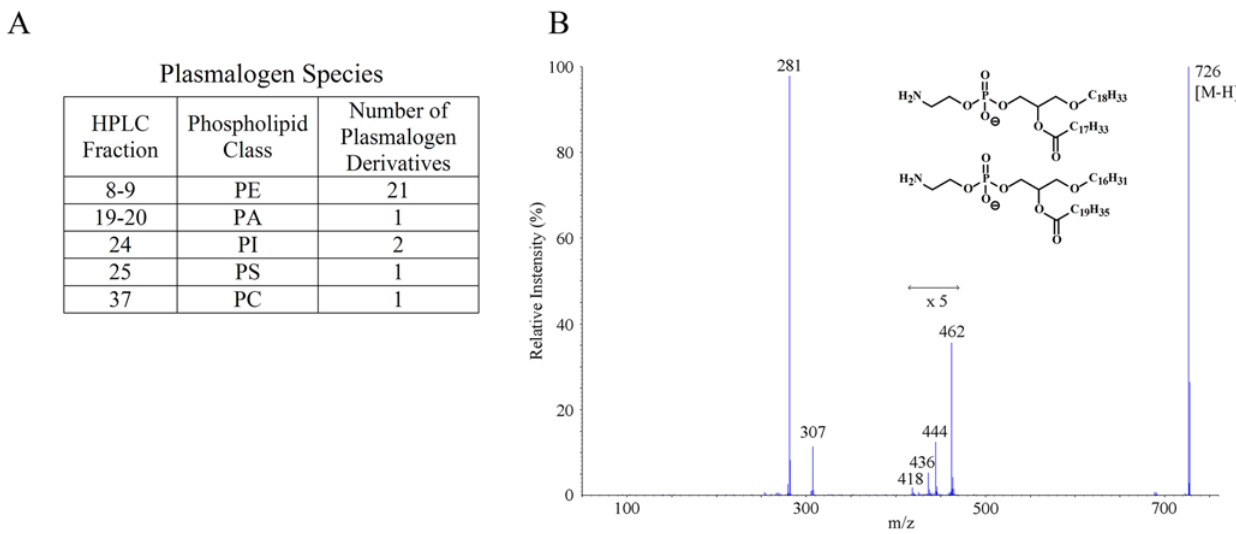
Figure 4. Identification of plasmalogens . A fraction of the diradyl phospholipid species within the CD1d ligand pool were identified as plasmalogens, as exemplified by the mass spectrometry data shown here. A ) Table summarizing the types of plasmalogen phospholipids identified. B ) Negative ion MS/MS of two PE ether plasmalogen species ( m / z 726.7), from the MS ion map of Fraction 9. Only the carboxylate ion was characterized. Ions m/z 462 and m/z 444 result from the loss of the 18:1 ketene and the 18:1 carboxylic acid respectively; ions m/z 436 and m/z 418 result from the loss of the 20:2 ketene and the 20:2 carboxylic acid respectively. The molecular formulas for the resulting ether moieties was deduced from the mass of the [M 2 H 2 ketene] 2 and [M 2 H 2 RCO 2 H] 2 ions. The structures of the ether moieties were not unequivocally determined. They